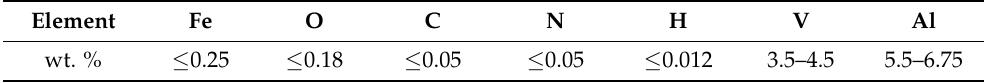
Table 1. Chemical composition of the Ti6Al4V in wt. %, Ti balance.